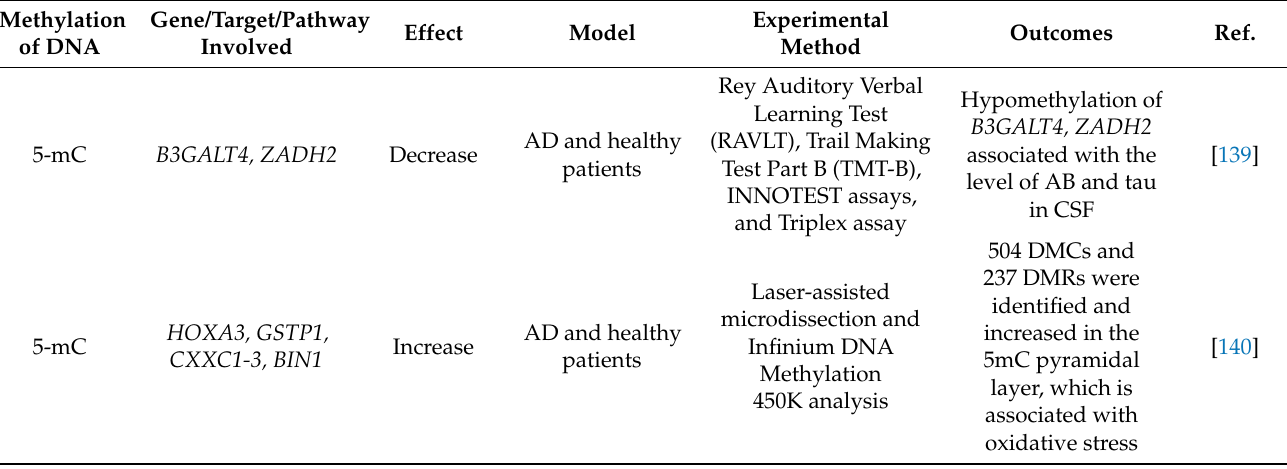
Table 2. Recent evidence supporting the role of DNA methylation in Alzheimer’s and Parkinson’s